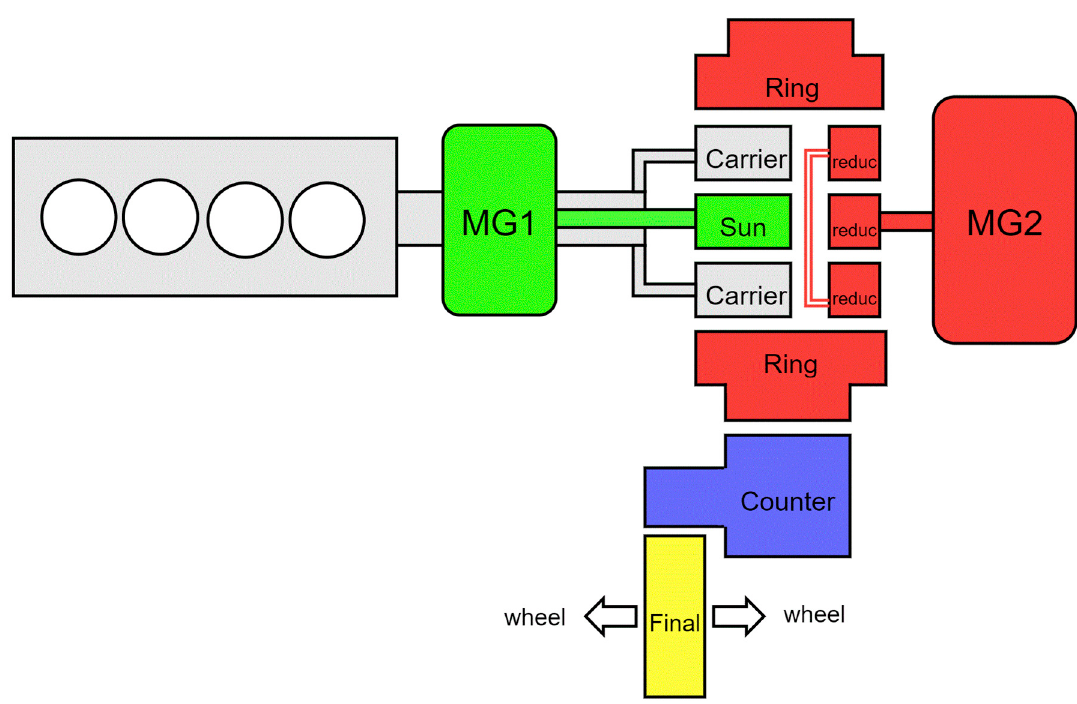
Figure 2. Prius3 powertrain structure.